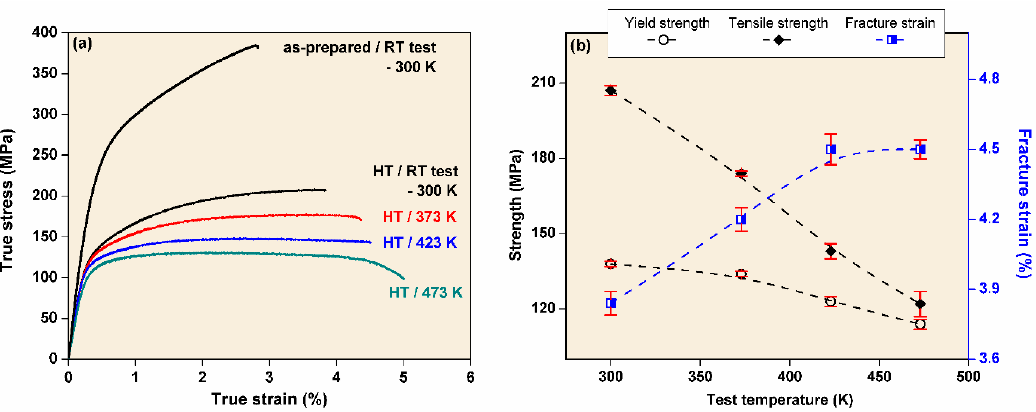
Figure 3. ( a ) Tensile true stress–strain curves for SLM-fabricated Al-12Si samples annealed at 573 K carried out at 300, 373, 423, and 473 K; ( b ) corresponding mechanical data.